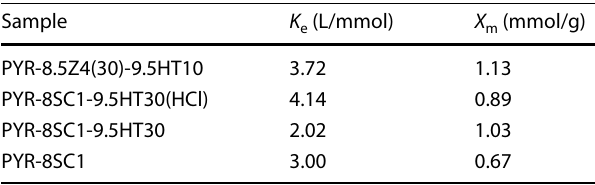
Table 5 Langmuir parameters for nitrate adsorption onto prepared samples